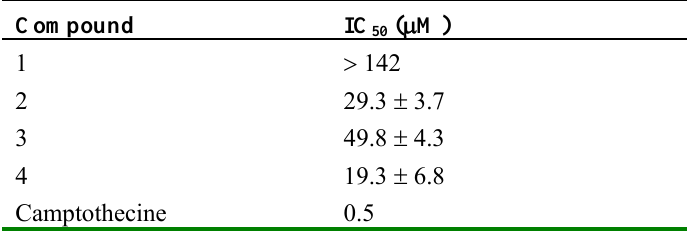
Table 2. Cytotoxicity data on Hela Cells for compounds 1 – 4 a